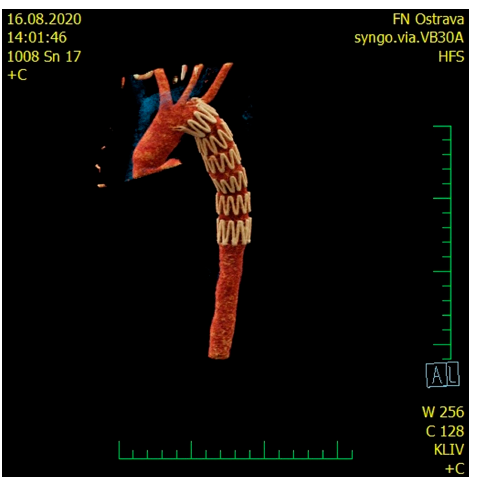
Figure 2. CT scan—large left-sided tension hemothorax with the mediastinal shift.